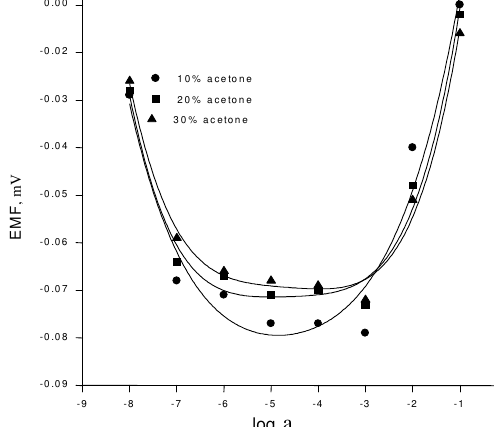
Figure 4(b). Effect of non- aqueous solvent-ethanol .